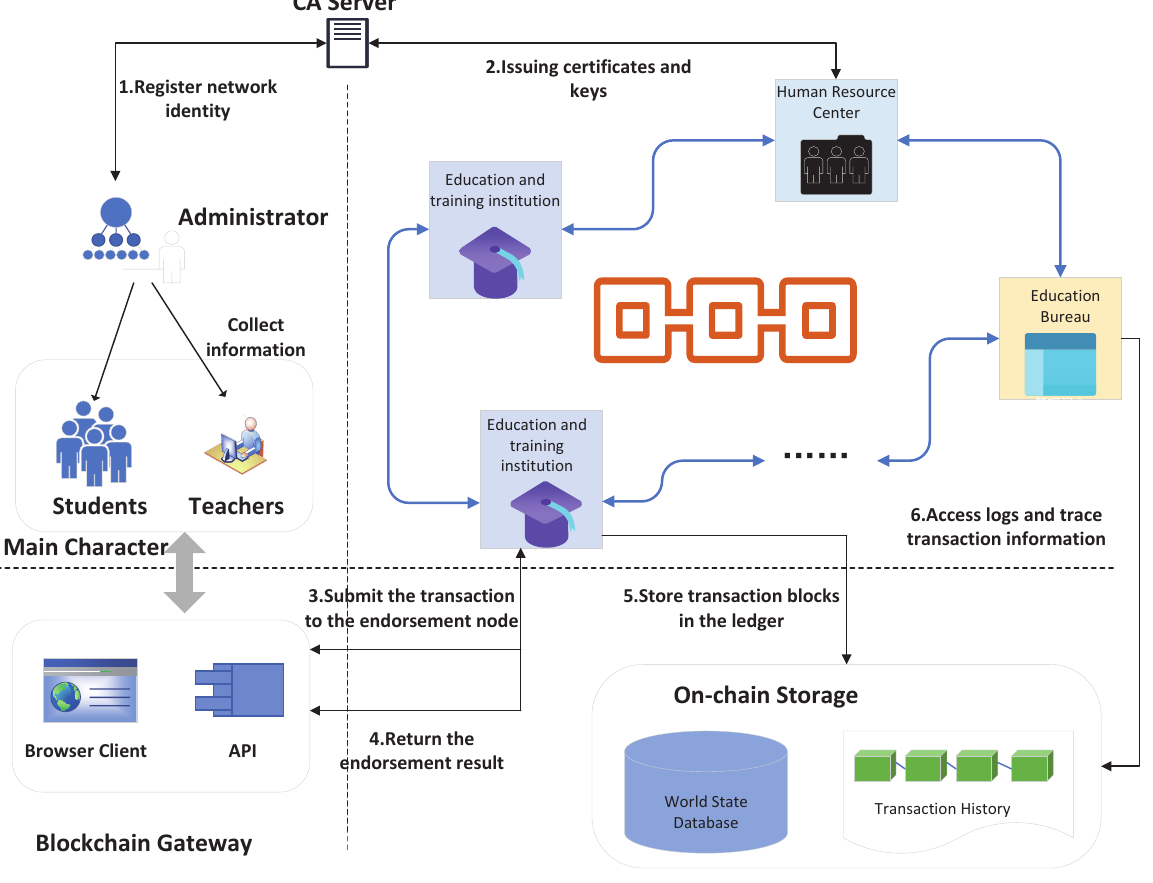
Figure 5. System